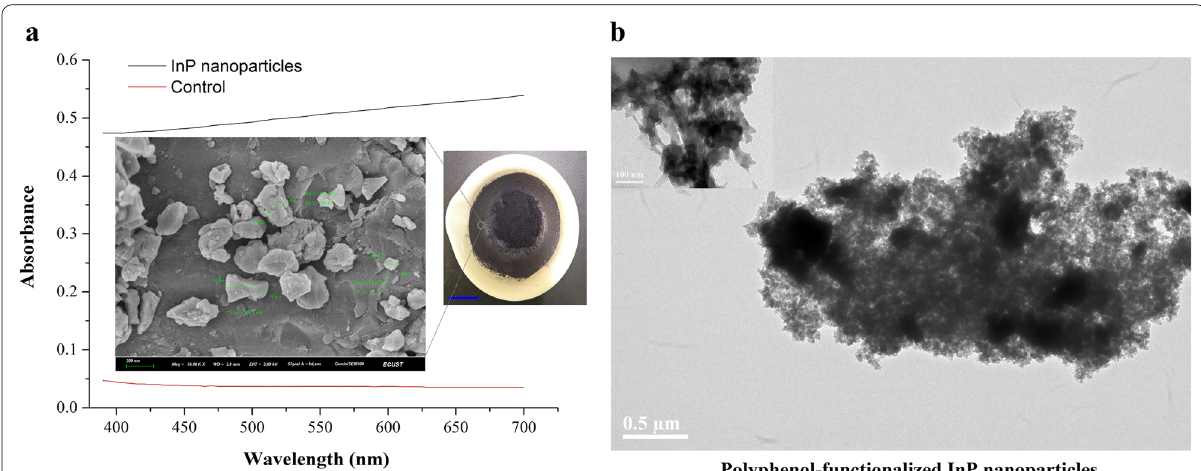
Fig. 5 Characterization of InP nanoparticles. a UV–Vis spectrum of InP nanoparticles suspension in ddH 2 O, and the control was spectrum of ddH 2 O. SEM image shows the morphology of InP after grinding and its size is distributed in 20–350 nm with less than 500 nm. Blue scale bar is 1 cm. b TEM image shows that InP nanoparticles were functionalized via (tannic acid)‑based coating. Tannic acid and InP form supramolecular networks on the surface of the nanoparticles resulted in InP is negatively